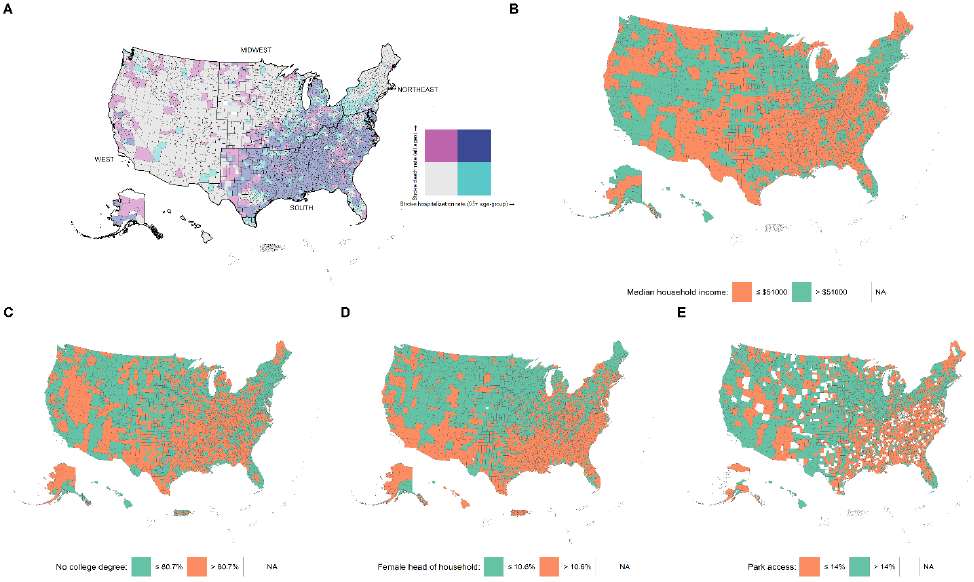
Figure 2. Map of US counties and county-equivalents showing ( A ) stroke hospitalization rate (SHR) among Medicare beneficiaries and stroke death rate (SDR), ( B ) median household income, ( C ) no college degree, ( D ) female head of household, ( E ) park access.